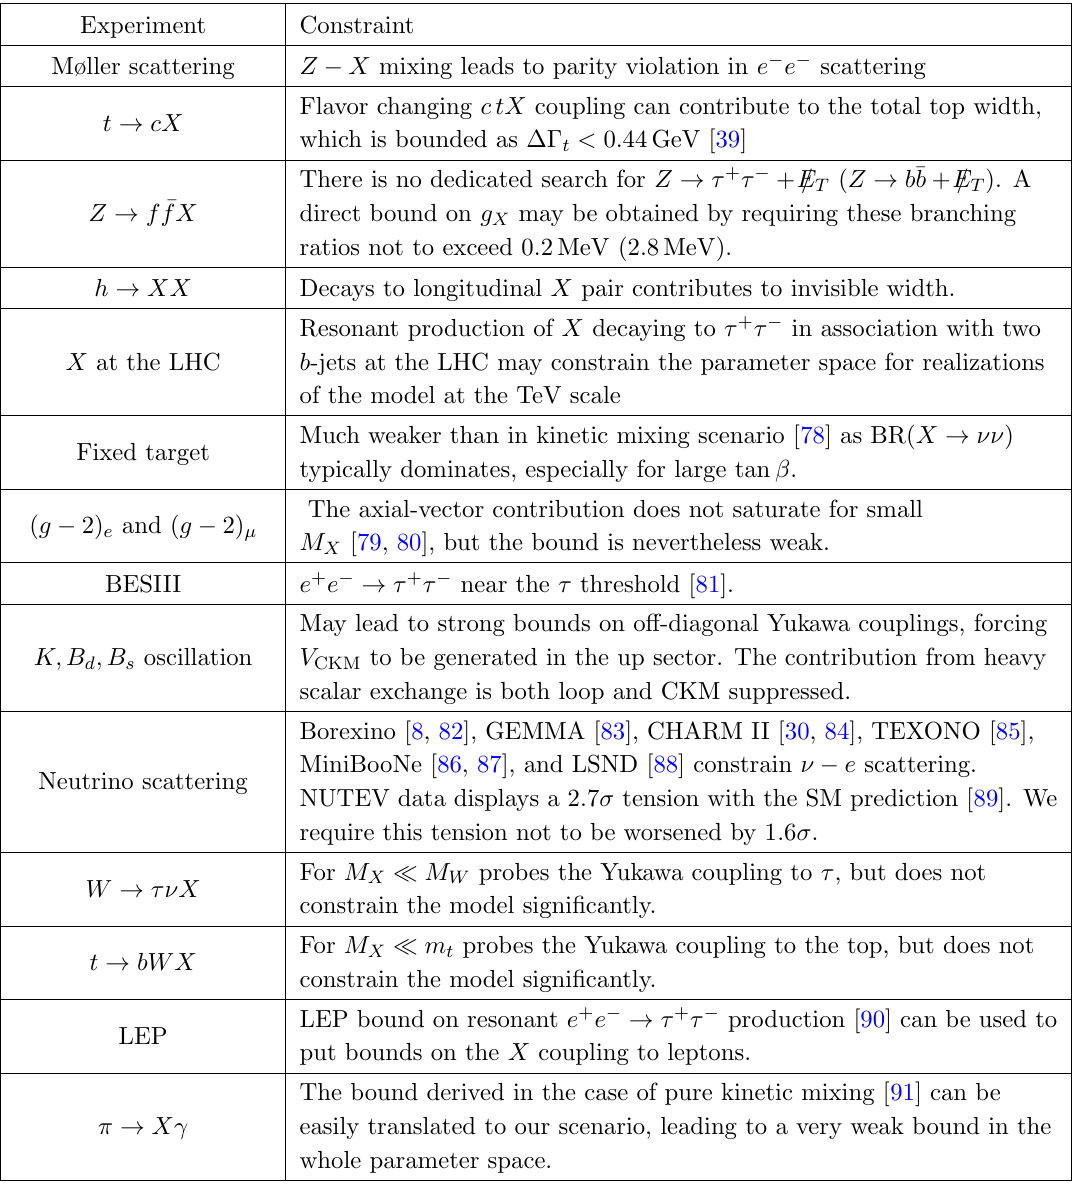
Table 3. List of constraints on the U(1) (3) gauge and scalar sector. For the neutrino scatter- B (cid:0) L ing bounds, the approximation of mean momentum transfer h q 2 i was made separately for each experiment. See section 4 for